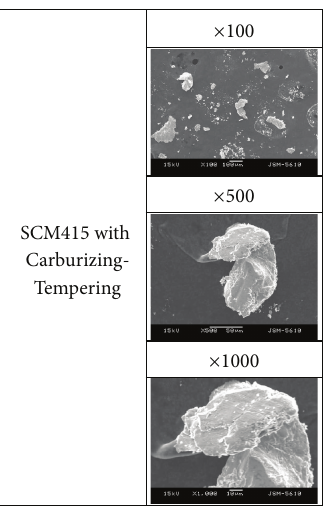
Figure 5: Representative SEM micrographs of wear particle for SCM415 with Carburizing-Tempering.